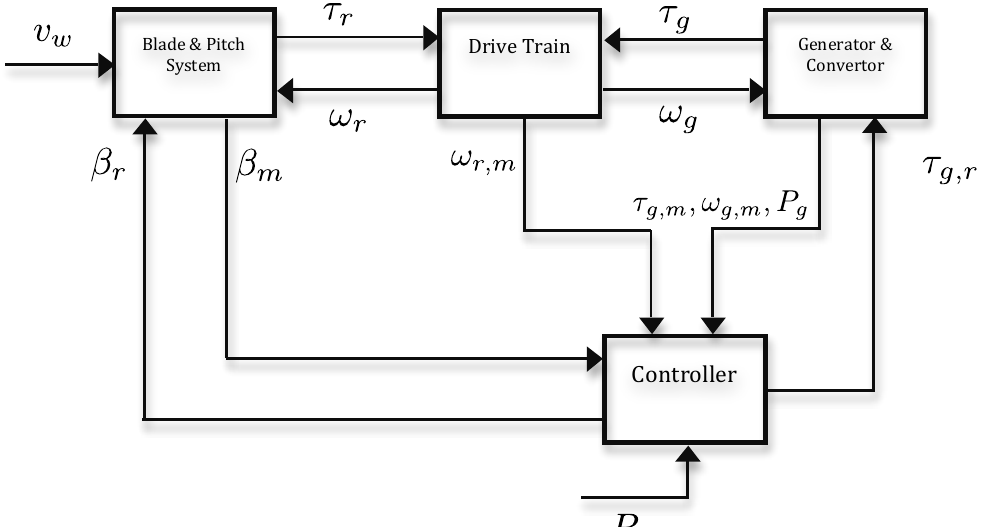
Figure 1. Block diagram of the wind turbine